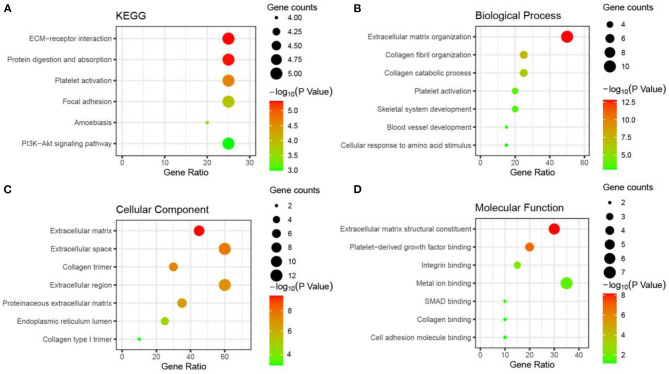
Gene ontology and KEGG pathway enrichment bubble diagram for shared DEGs (showing the first seven items).